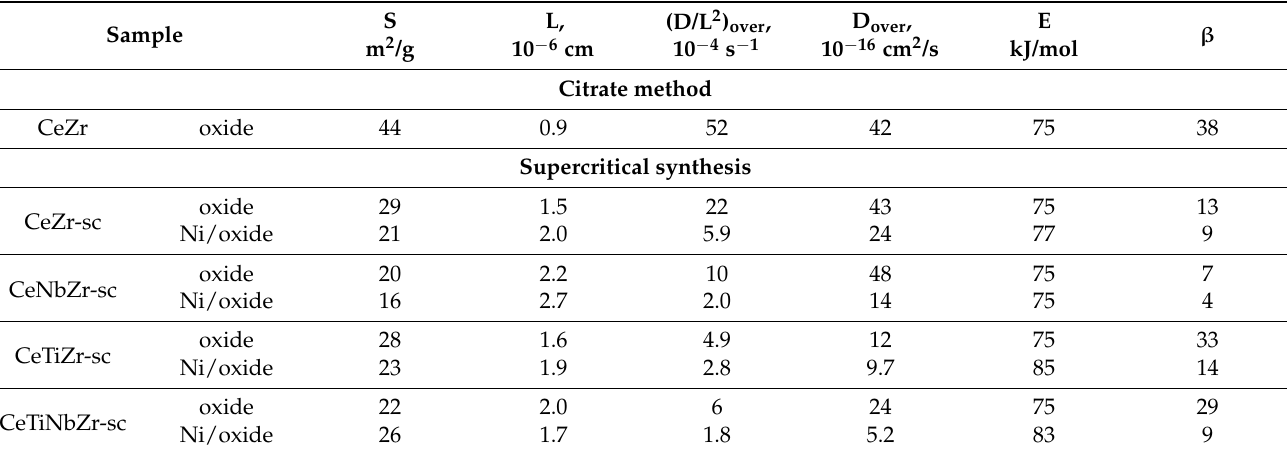
Table 5. Weighted average oxygen tracer diffusion coefficients for samples at 600 ◦ C and their effective activation energies according to TPIE with C 18 O 2